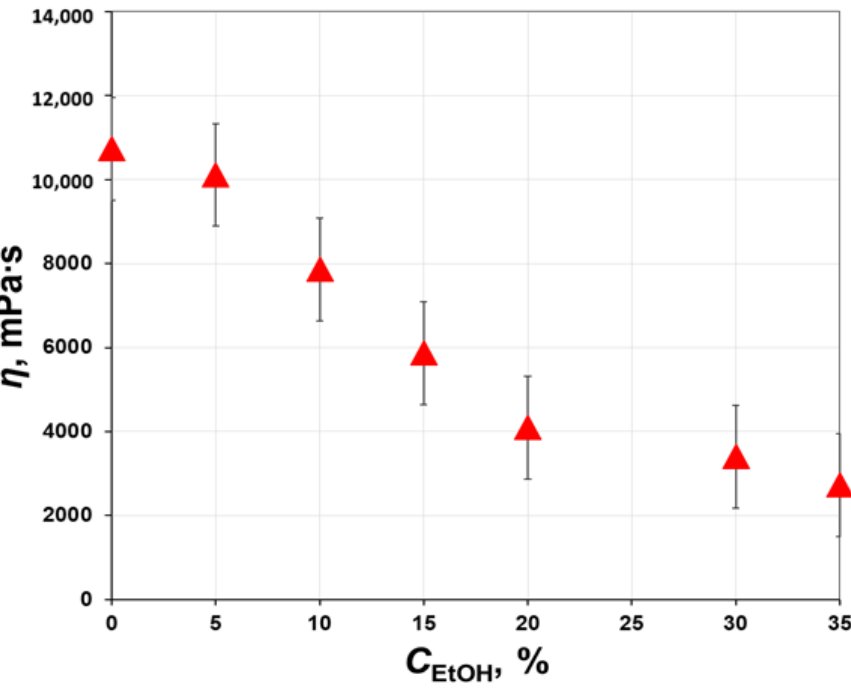
Figure 6. The e ff ect of ethanol content on the viscosity of 12 wt.% PAA solution in